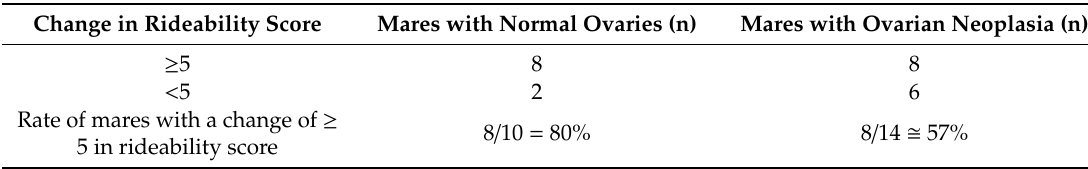
Table 3. Change in rideability score after bilateral ovariectomy in mares with and without ovarian neoplasia. A change in score of ≥ 5 was considered a marked positive change in behaviour following ovariectomy. Four horses were excluded due to no histologic examination.